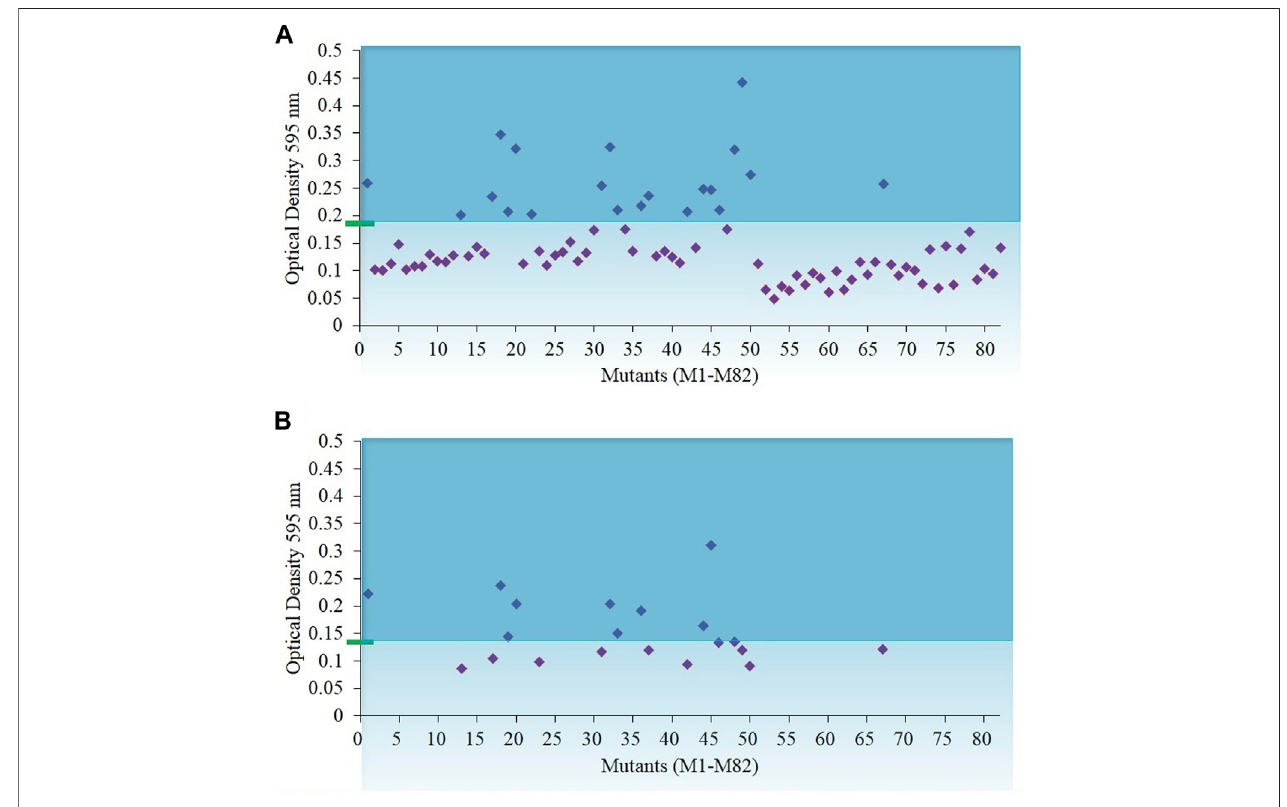
FIGURE 2 | Biomass density of N. oculata mutants after eight days of growth in f/2 medium containing cerulenin. The initial optical density of 595 nm was 0.15 at day 0 (A) Optical density of 82 N. oculata mutants in 50 µM cerulenin. (B) Optical density of 20 N. oculata mutants containing 60 µM cerulenin. The cultures were